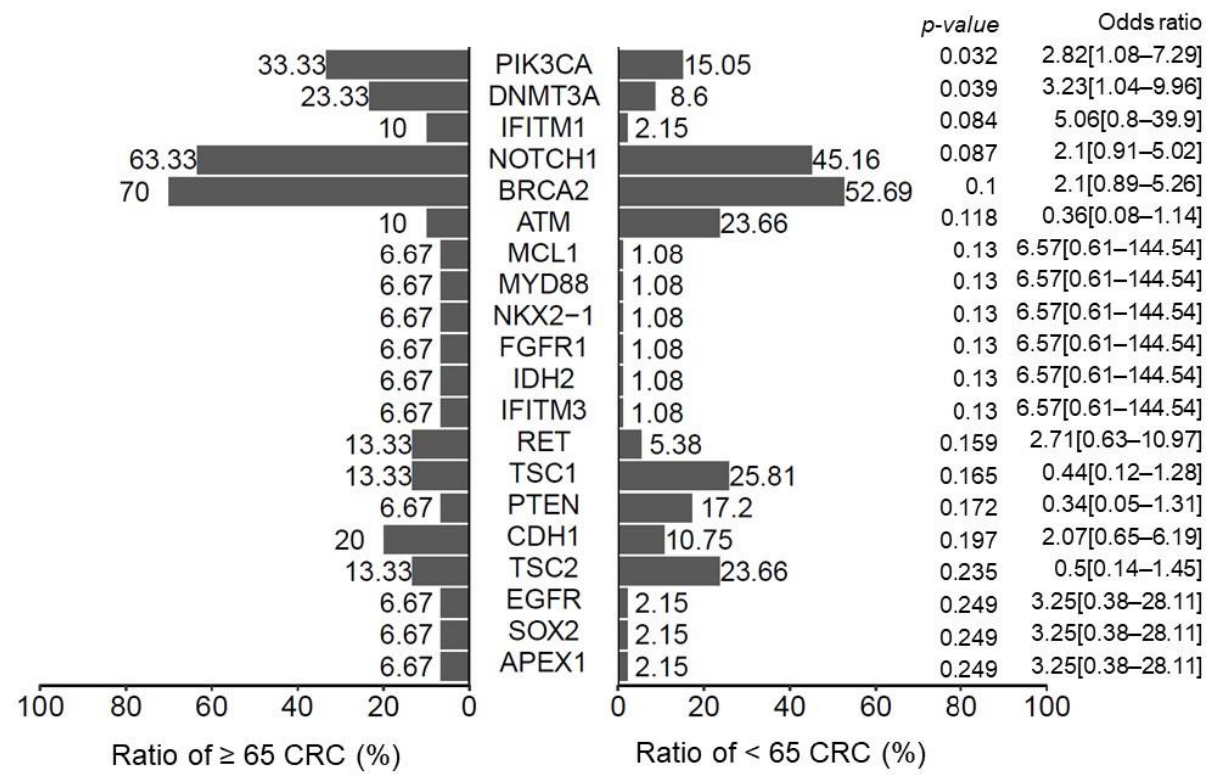
Figure 5. Histogram showing the percentage of genetic mutations in patients with CRC. We divided the patients into two subgroups: age ≥ 65 years and age < 65 years. The p -value was calculated using the Fisher exact test. In total, 30 (24.3%) patients were older than 65 years and PIK3CA and DNMT3A mutations were more prominent in these patients.